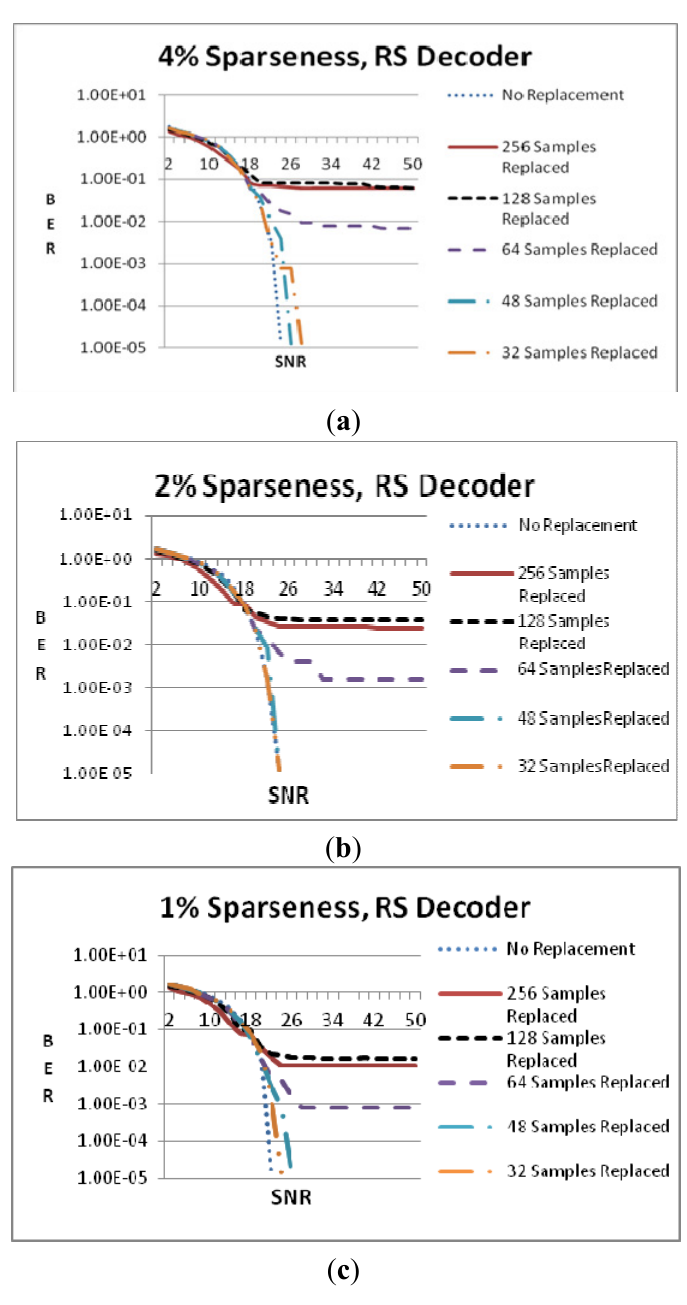
Figure 7. BER vs. SNR when RS decoder is used and the data sparseness is ( a ) 4%; ( b ) 2%; ( c )